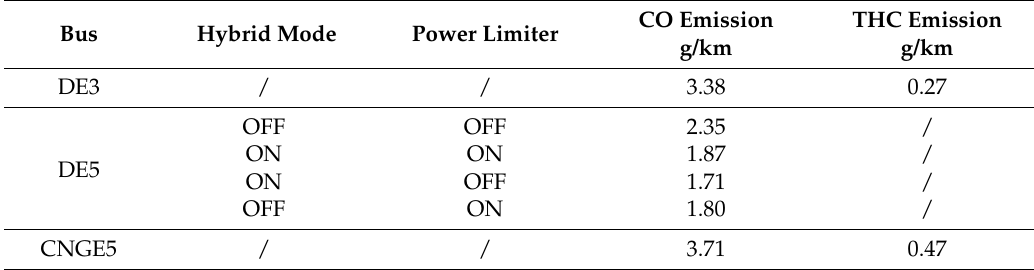
Table 3. Average CO and THC specific mass emissions for observed